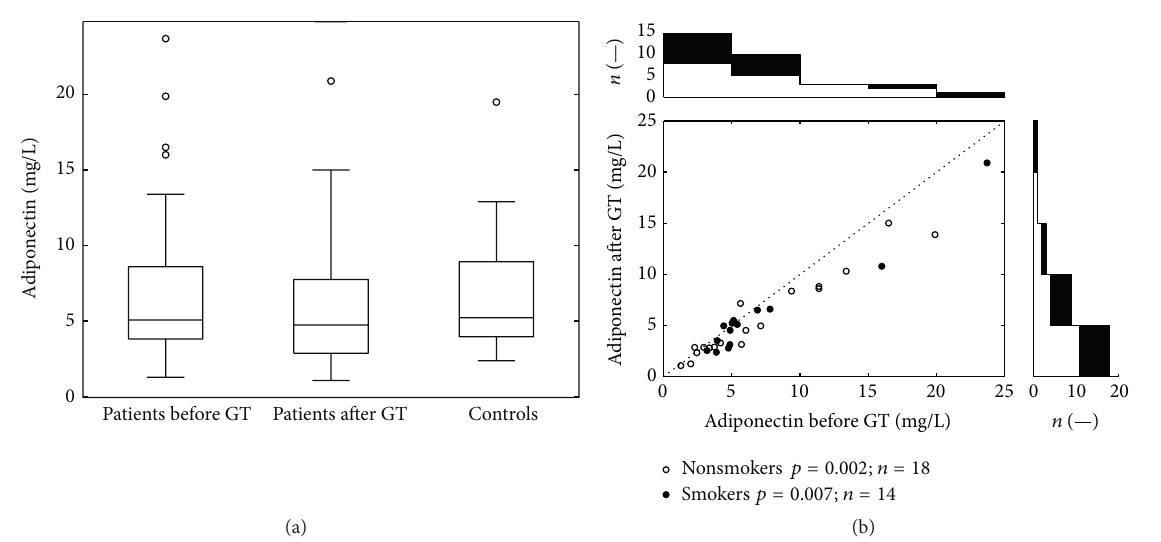
Figure 3: The variation in adiponectin values. (a) depicts intergroup comparisons of serum levels of adiponectin using Wilcoxon rank sum test (patients before and after GT versus controls). The test did not show any intergroup differences. (b) (scatter plot) depicts serum adiponectin levels before and after GT in patients. Pairwise comparison of patients (before versus after GT) by Wilcoxon signed rank test showed significantly higher levels of adiponectin before GT for the whole group ( 𝑝 < 0.001 ). For smokers (black dots) and nonsmokers (open circles) statisticsseetheplot legend. All together 32 dotsrepresent 64measurements; each dot belongs toonepatient. Thetop histogramshows data distribution before the treatment; the right side histogram corresponds to the after treatment values